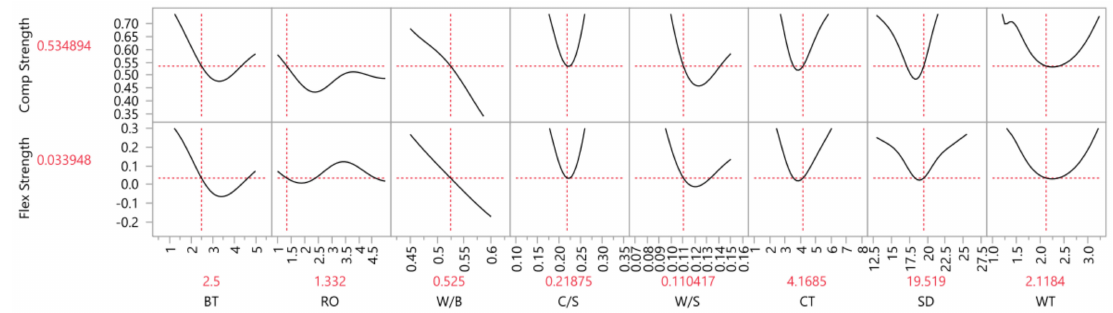
Figure 12. Prediction profiles for compressive and flexural strength with respect to factors.